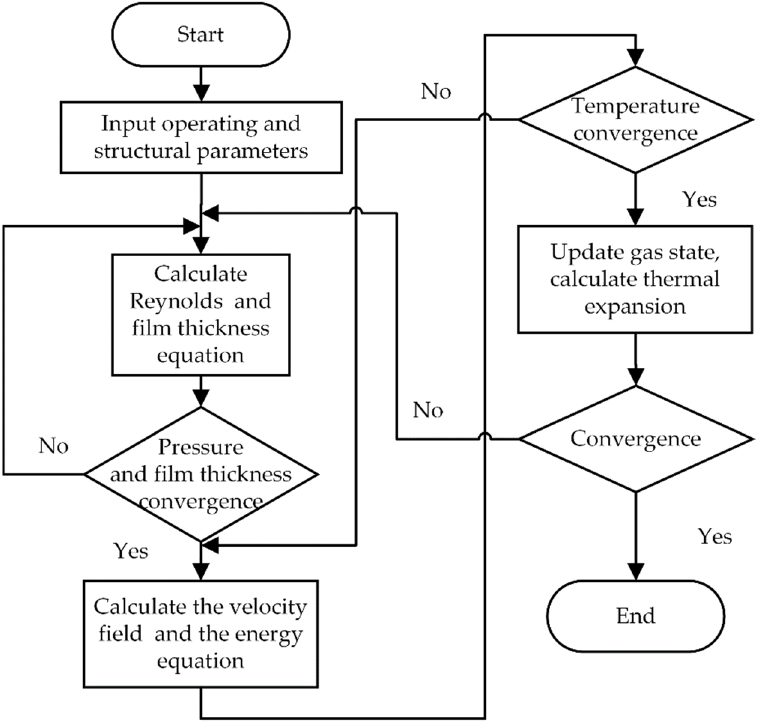
Figure 7. Algorithm of the air-thermoelastic coupling simulation.